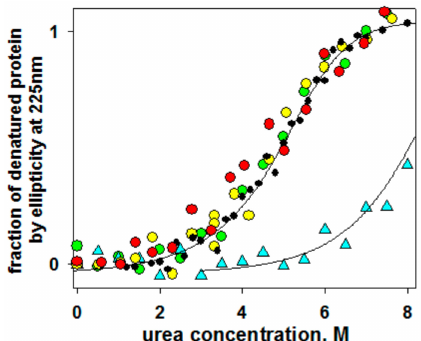
Figure 4. Dependency of fraction of denatured state calculated by ellipticity at 225 nm on urea concentration in protein samples at pH 7.2: Wild type (black circles) and four oxidized double-cysteine mutant forms, V11C–D36C (red circles), Q111C–V93C (orange circles), K162C–Q184C (green circles), S202C–T225C (cyan